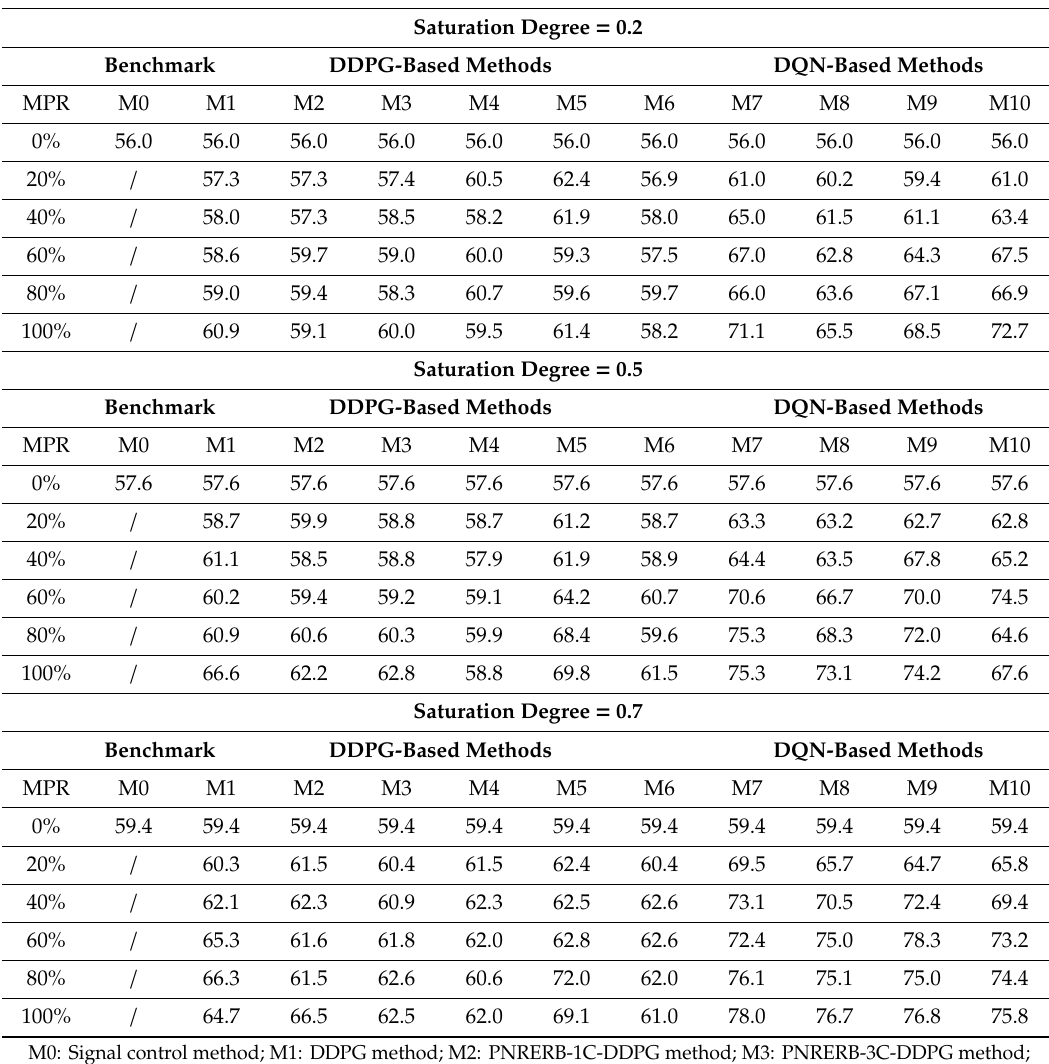
Table 2. ATT results of di ff erent